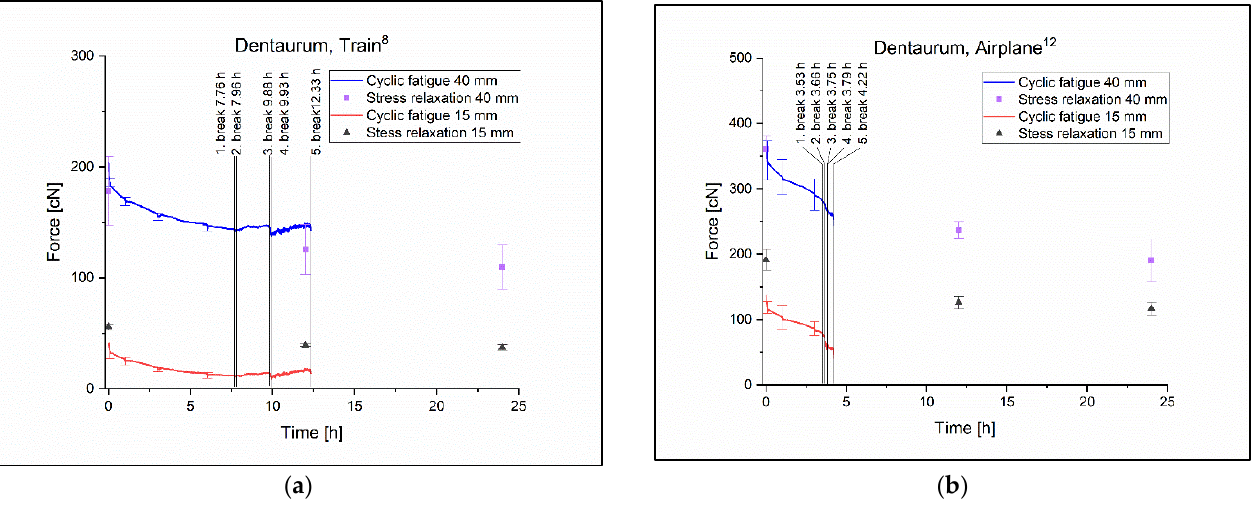
Figure 7. ( a ) The Train 8 ligature cyclic and relaxation diagram with the times at break. ( b ) The Parrot airplane 12 cyclic and relaxation diagram with the times at break. Table 4. The cyclic fatigue tests’ Tukey statistics in the case of Train 8 and Airplane 12 ligatures. There was only one intact ligature at the 12 h; therefore, the statistic was calculated to 6 h. The orange color indicates the significant difference with 95% confidence